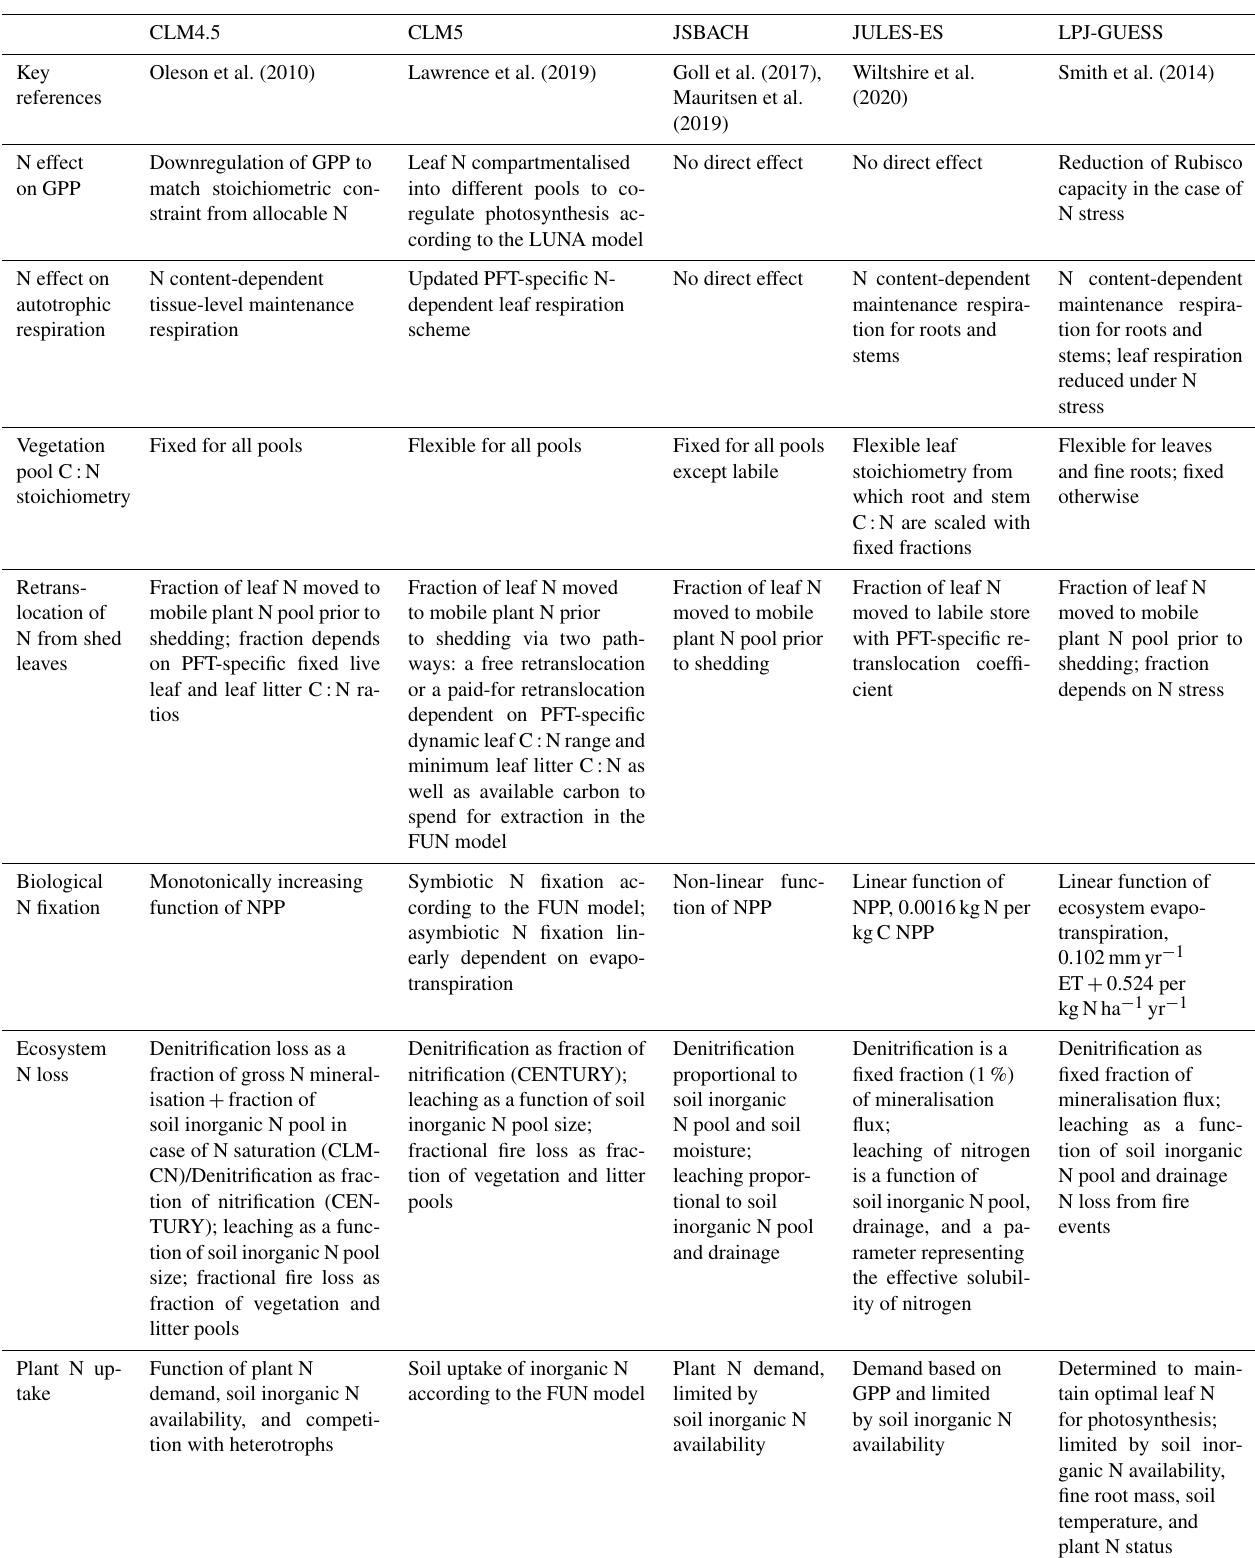
Table 1. Key nitrogen cycle algorithms applied by the models. C is Carbon; N is Nitrogen; GPP is gross primary productivity; NPP is net primary productivity; and PFT is plant functional